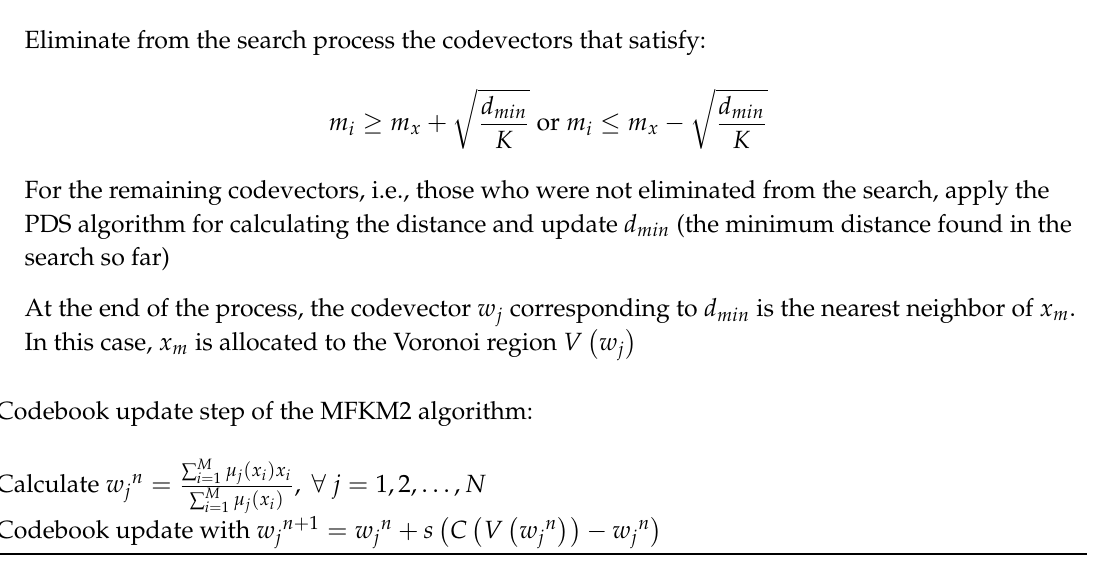
Algorithm 3. Partitioning step of the MFKM2 algorithm in crisp mode with the use of ENNS (Calculate off - line the mean of each input vector)